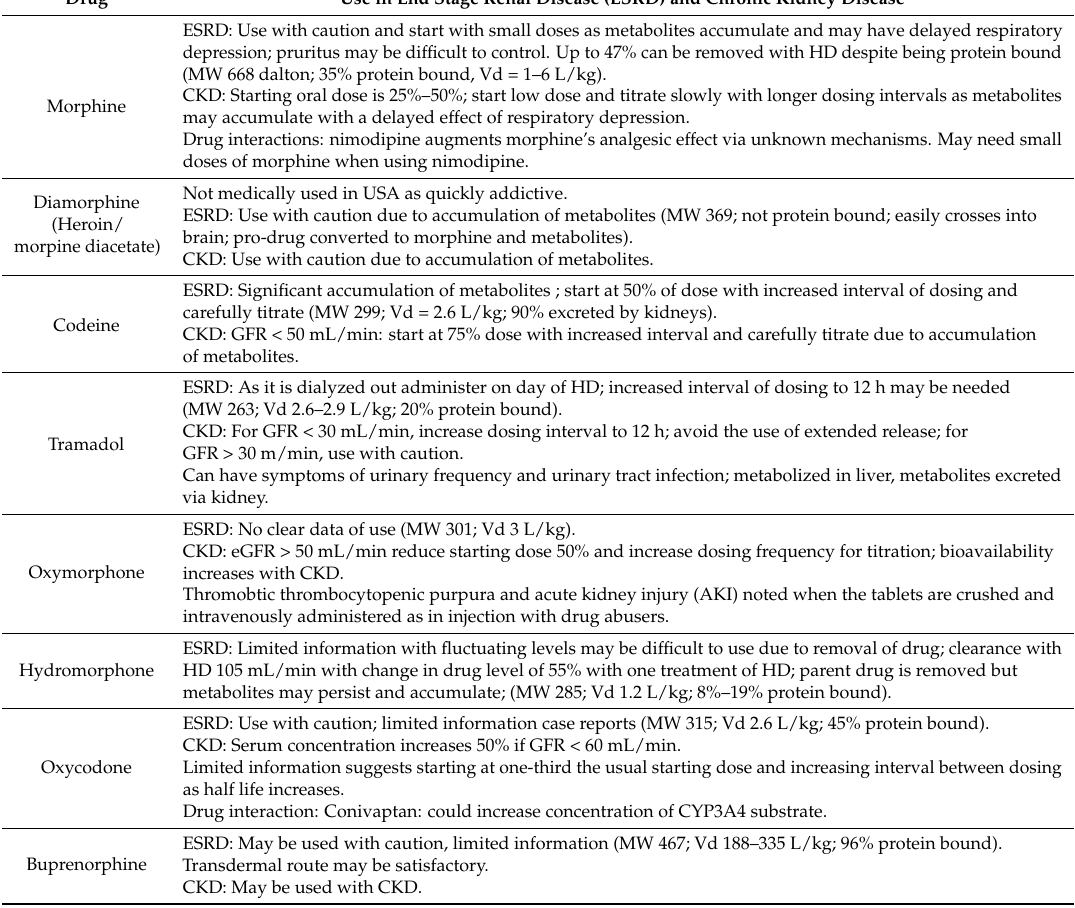
Table 4. Opioids and use in chronic kidney disease (CKD). In general, with CKD use opioids with caution; with decreased renal function, dose and timing interval may need to be adjusted. This is particularly true for agents that are used for chronic pain where a steady state has been reached with distribution of drug and metabolites into various compartments (versus limited use peri-operatively or for anesthesia). While opioids are used safely in CKD for both pain control and anesthesia, it is the chronic use of opioids and the level of CKD that alter the pharmacokinetics of the drugs and causes metabolites to accumulate that lead to unwanted side effects. With CKD, it is important to note that the non-renal clearance of medications is altered with variations in the phases of drug metabolism. In addition, it is with chronic use that accumulation and steady-state distribution of drugs, intermediate compounds and metabolites in various compartment occur, which may result in unwanted side